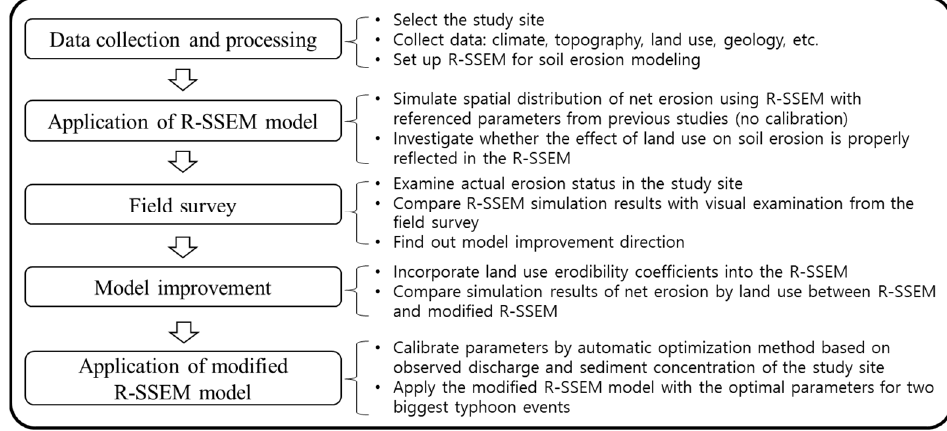
Figure 1. Research flowchart of this study.